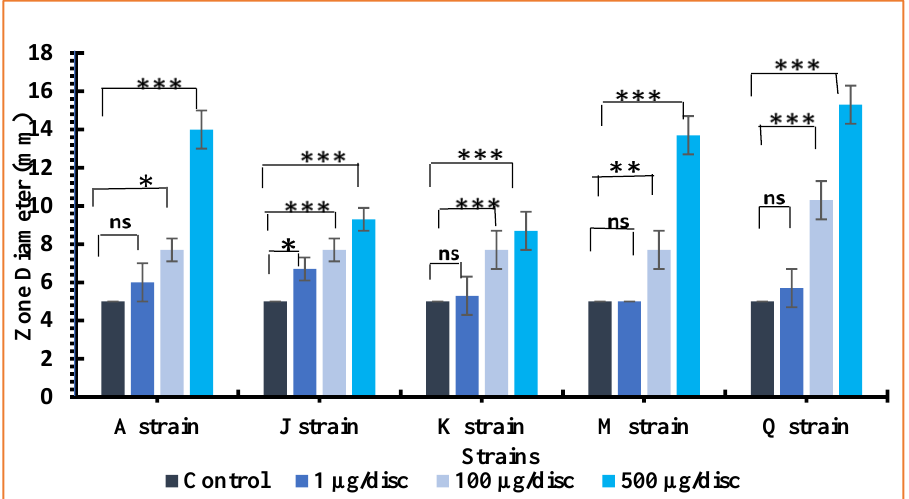
Figure 7. The zone diameter at different concentrations of H 3 L on Strains, Klebsiellapneumoniae (A), Staphylococcus aureus (J), Streptococcus pneumonia (K), Vibrio cholerae (M) & Shigella boydii (Q). Data are represented as mean ± SD of three concentration of doses (* p < 0.05, ** p < 0.01, *** p < 0.001, ns—no significance p > 0.05).